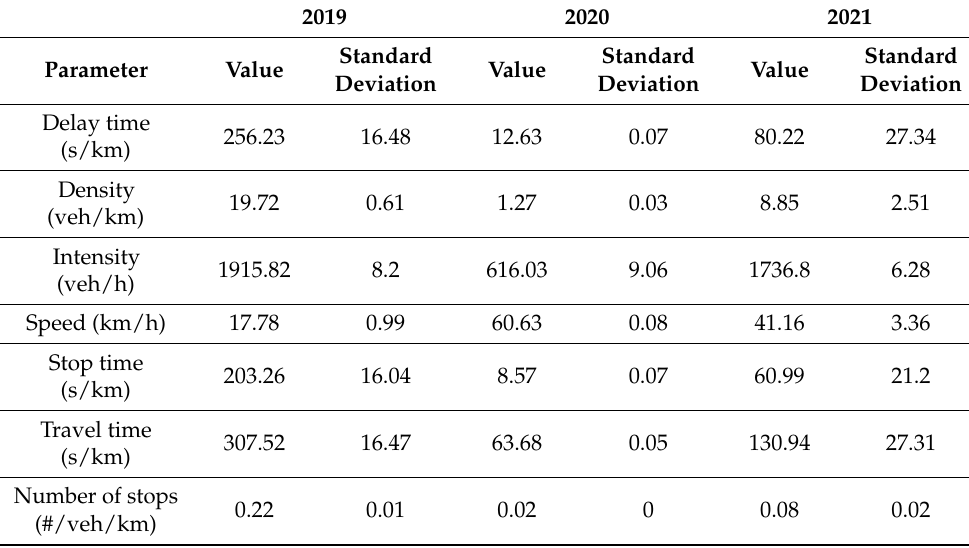
Table 2. Resulting values of traffic parameters as simulation output.